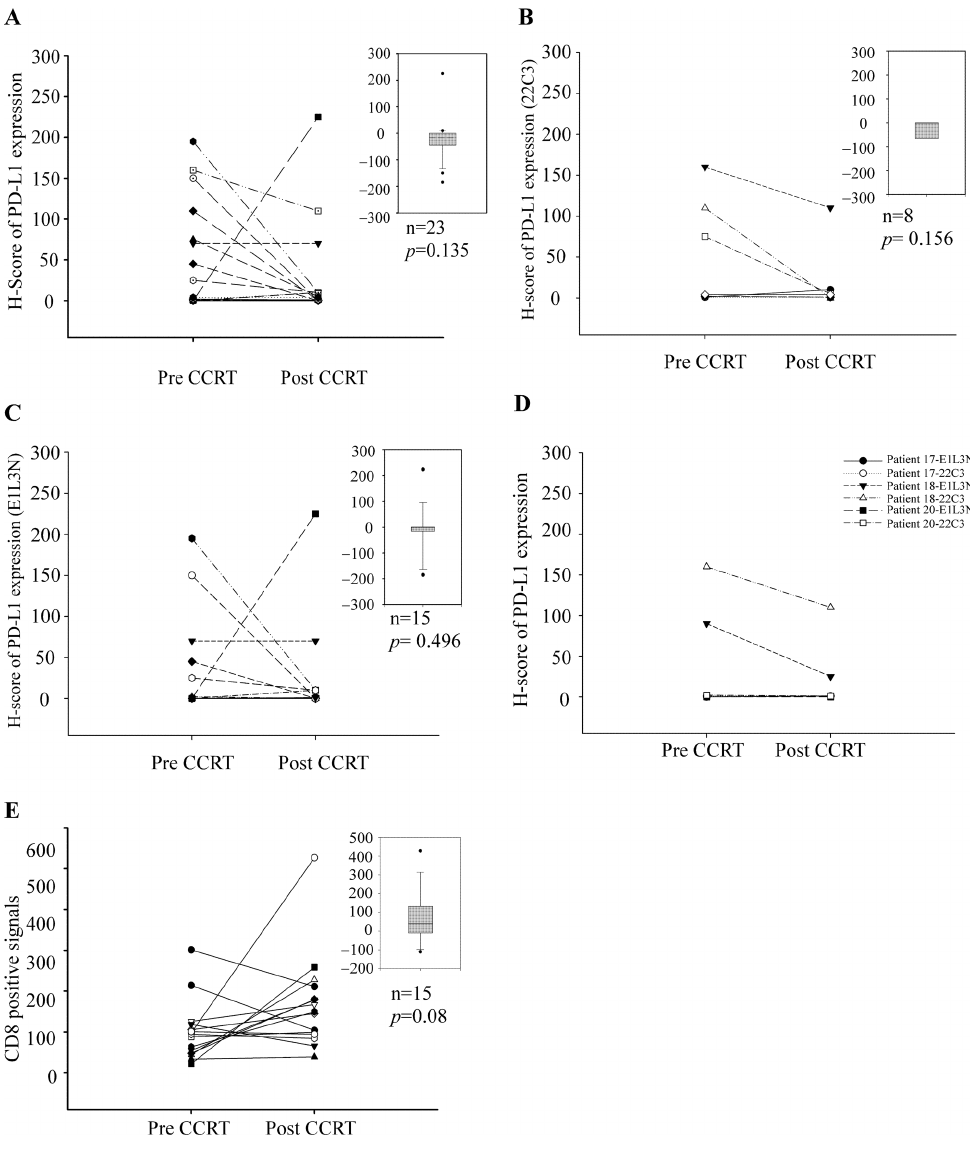
Figure 2. Decreased tumor PD-L1 H score after concurrent chemoradiotherapy treatment. ( A ) Quan- tification of PD-L1 expression before and after CCRT treatment in 23 paired patients. ( B ) Quantifi- cation of PD-L1 expression before and after CCRT treatment in the other 8 paired patients with anti- PD-L1 22C3 clone. The p value is 0.156 with Wilcoxon signed-rank test. ( C ) Quantification of PD-L1 expression before and after CCRT treatment in 15 paired patients with anti-PD-L1 E1L3N clone. The p value is 0.496 with Wilcoxon signed-rank test. ( D ) Quantification of PD-L1 expression before and after CCRT treatment in 3 paired patients with both anti-PD-L1 E1L3N and 22C3 clone. ( E ) Quanti- fication of CD8 expression before and after CCRT treatment in 15 paired patients. The p value is 0.08 with Wilcoxon signed-rank test. Abbreviations: CCRT, concurrent chemoradiation therapy.